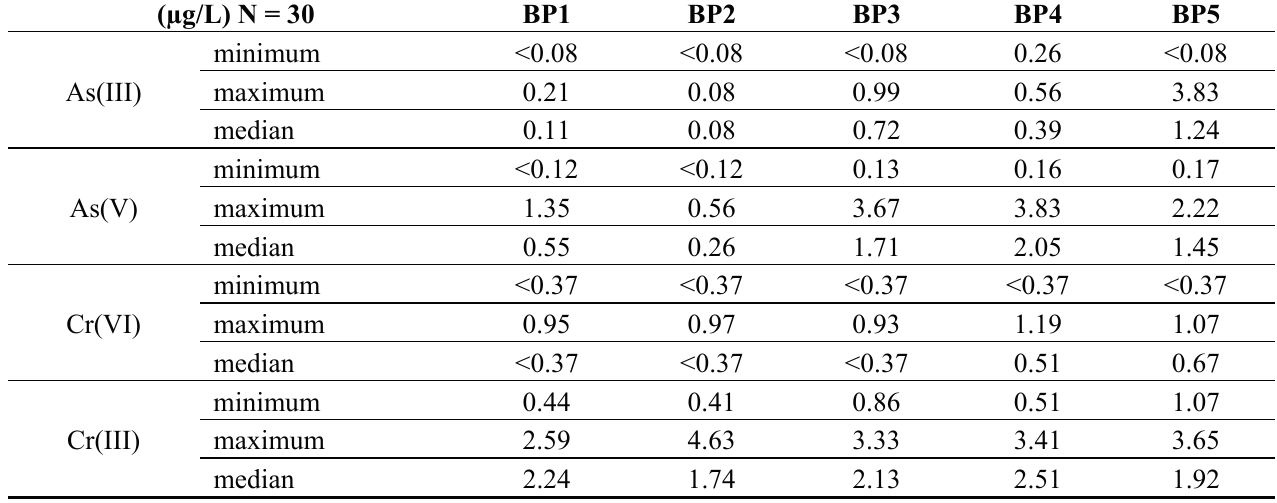
Table 6. Minimum, maximum and median contents of the arsenic and chromium speciation forms in the Bia ł a Przemsza River water; sampling points: BP1—Chrz ą stowice;